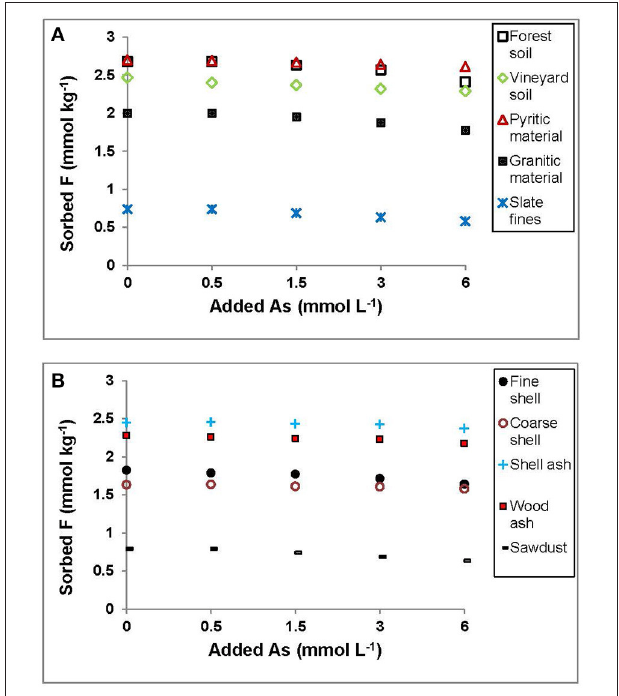
FIGURE 3 | Sorption results (mmol kg − 1 ) for F − on the soils, by-products and waste materials studied, when the concentration of F − added is always 3 mmol L − 1 and added As(V) is increased from 0 to 6 mmol L − 1 . Average values (three replicates), with coefficients of variation <